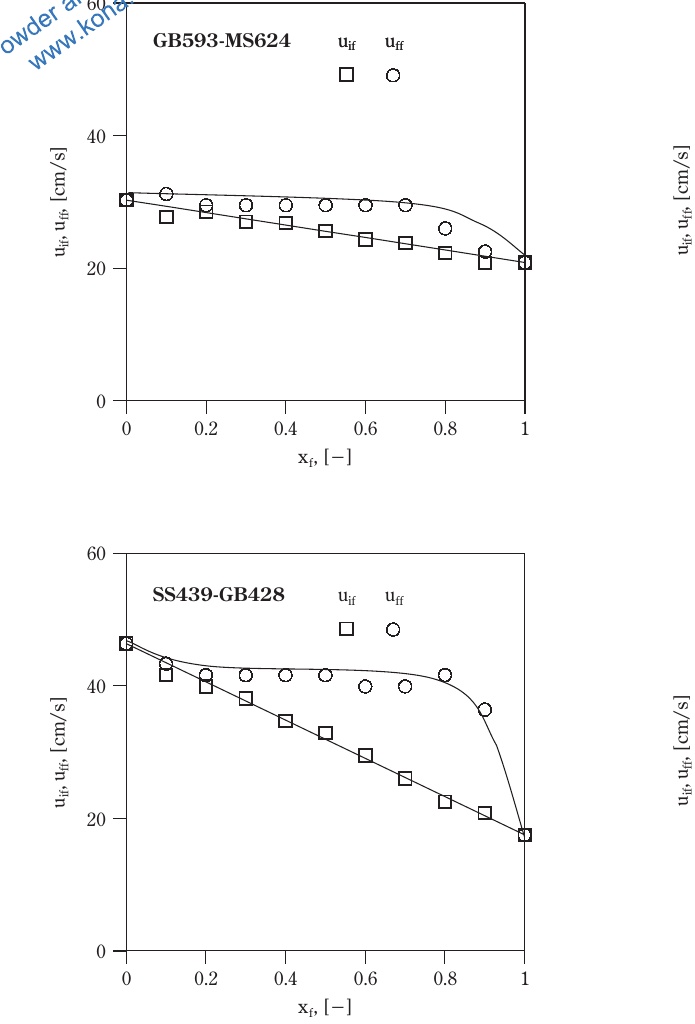
Fig. 8 Fluidization velocity range of density segregating mix- tures. Segregated